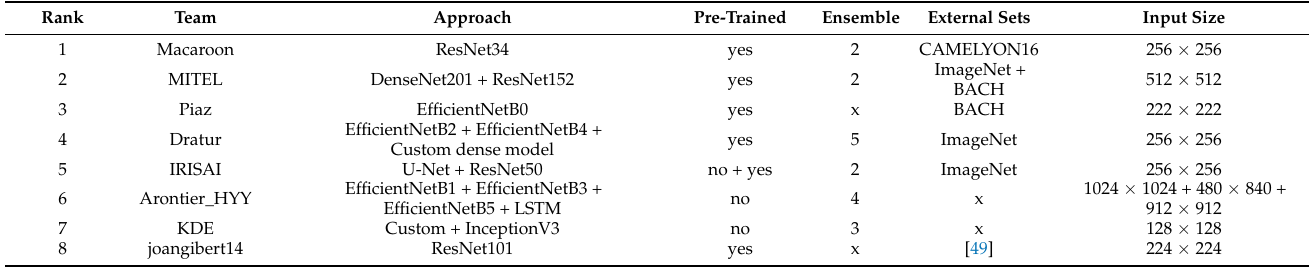
Table 6. Main characteristics of the submitted methods. “Approach” lists the main methods used to classify the WSI; “pre-trained” indicates whether the transfer learning approach was used; “ensemble” indicates whether the method uses one or multiple models, and their number; “external sets” indicates external datasets used in pre-trained models; “input size” indicates the size, in pixels, of the images or tiles required by the model (WSI signifies that the entire WSI was input into the model at the same time).